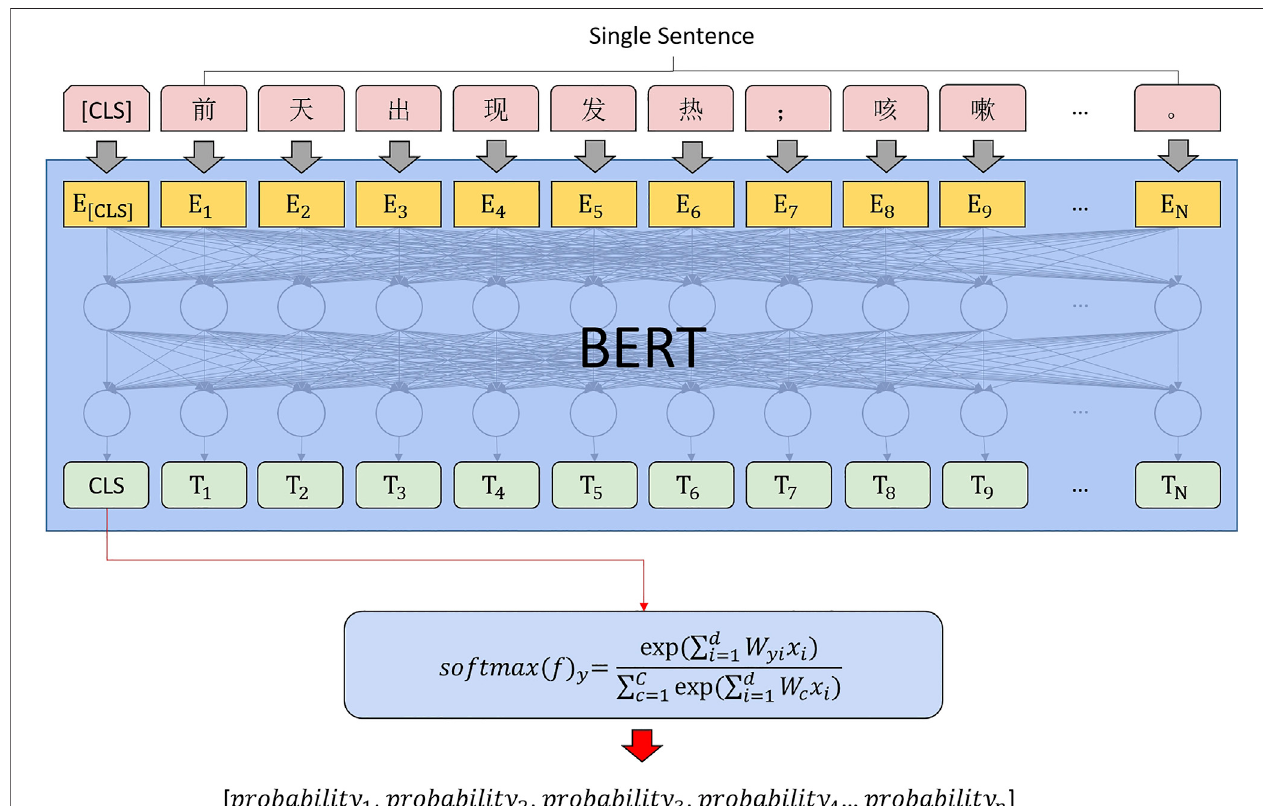
FIGURE 6 | Sentence classi fi cation computing